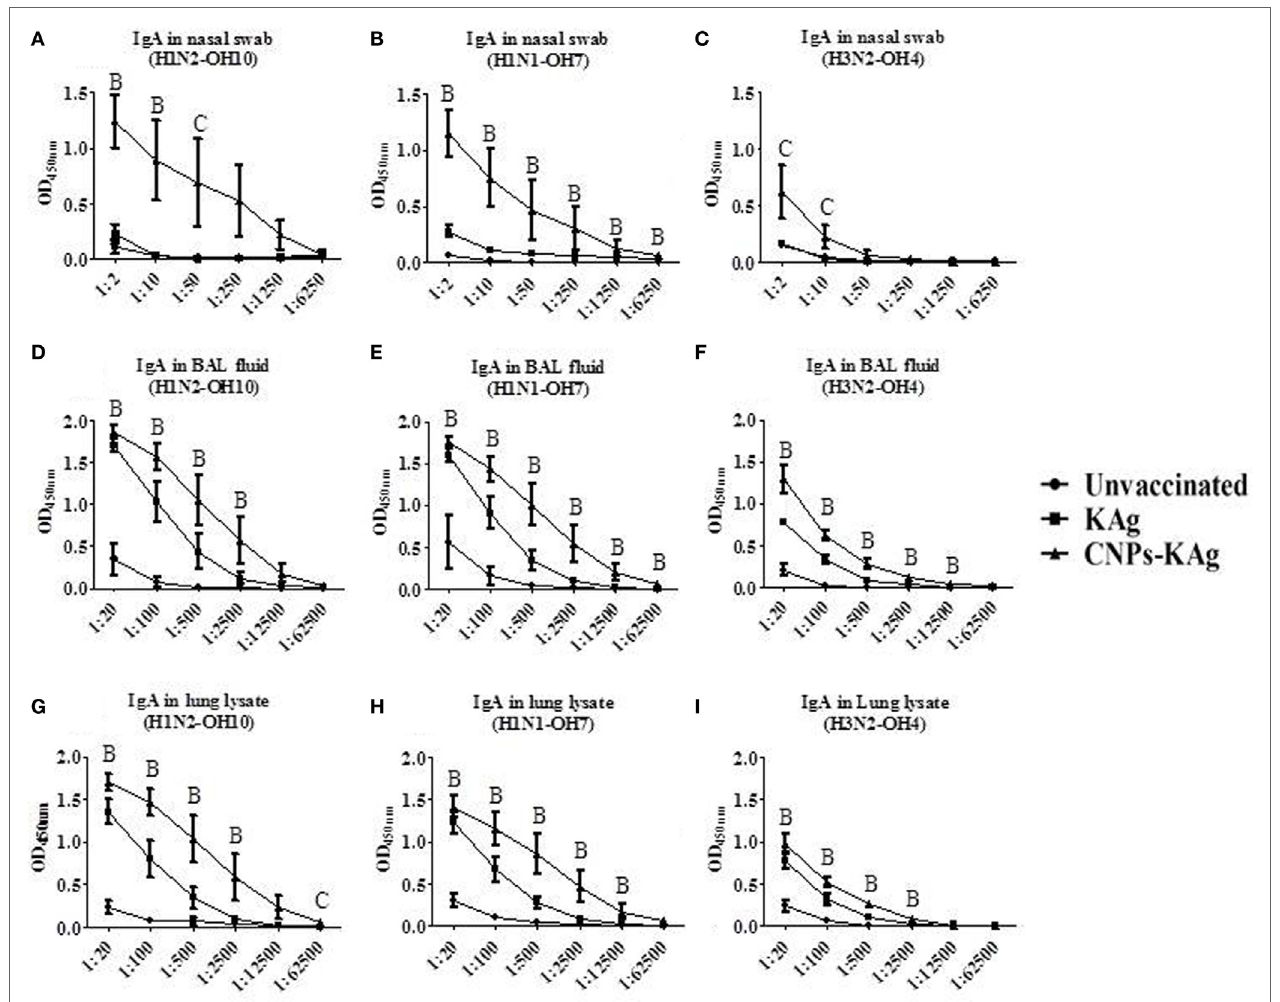
FigUre 5 | Mucosal IgA antibody response in the respiratory tract of pigs vaccinated with chitosan nanoparticles (CNPs)-KAg at day post-challenge 6. Specific IgA antibody response in nasal swab, bronchoalveolar lavage (BAL) fluid, and lung lysate samples against H1N2-OH10 (a,D,g) , H1N1-OH7 (B,e,h) , and H3N2-OH4 (c,F,i) influenza A virus (IAVs). Data represent the mean value of three to five pigs ± SEM at all indicated dilutions. Statistical analysis was carried out using Kruskal– Wallis test followed by Dunn’s post hoc test where A, B, and C refer to significant difference ( p < 0.05) between unvaccinated vs KAg vaccinates, unvaccinated vs CNPs-KAg vaccinates, and KAg vs CNPs-KAg vaccinates, respectively, at the indicated